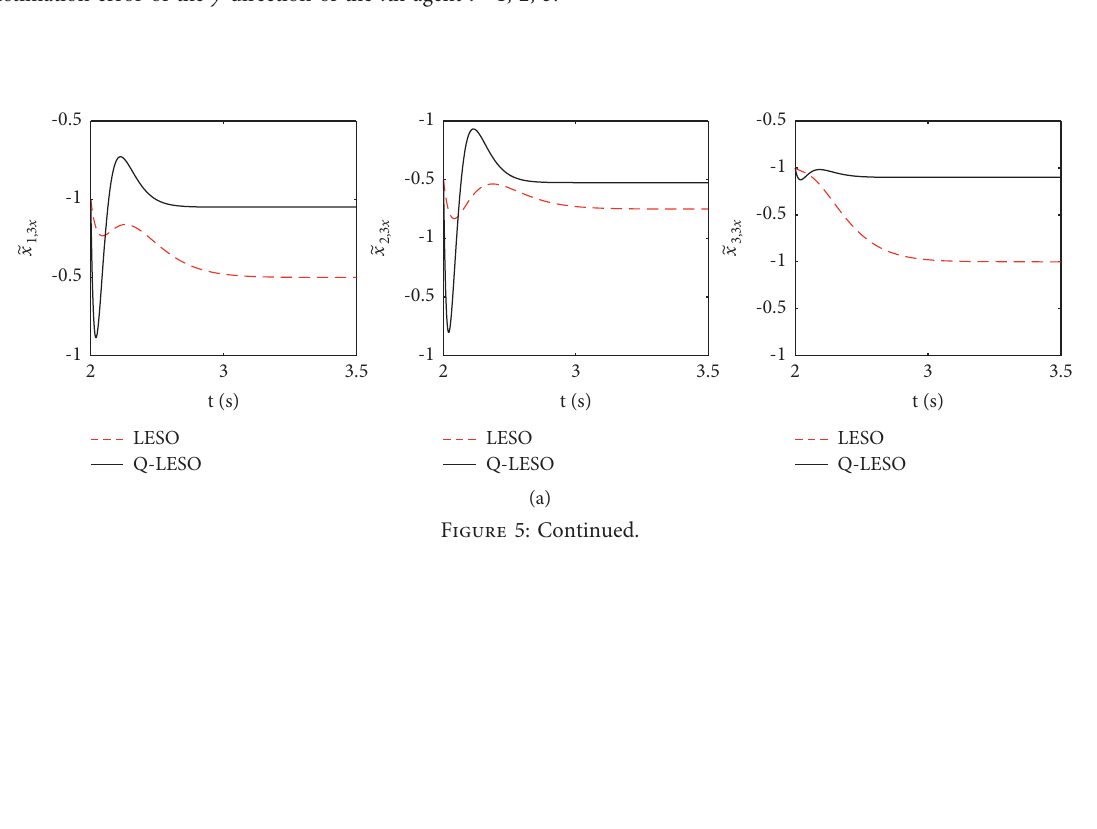
Figure 4: The velocity estimation error 􏽥 x i, 2 in Case A. (a) The velocity estimation error of the x -direction of the i th agent i velocity estimation error of the y -direction of the i th agent i � 1, 2,